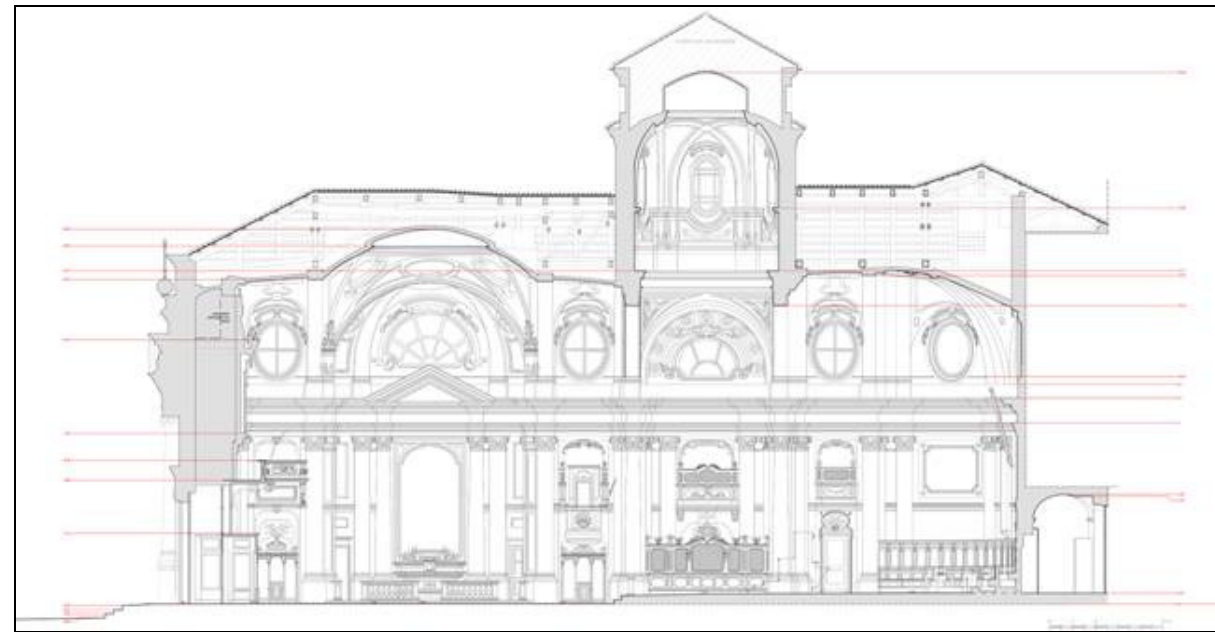
Figure 1 - Relief of Chiesa della Misericordia in Turin – scale